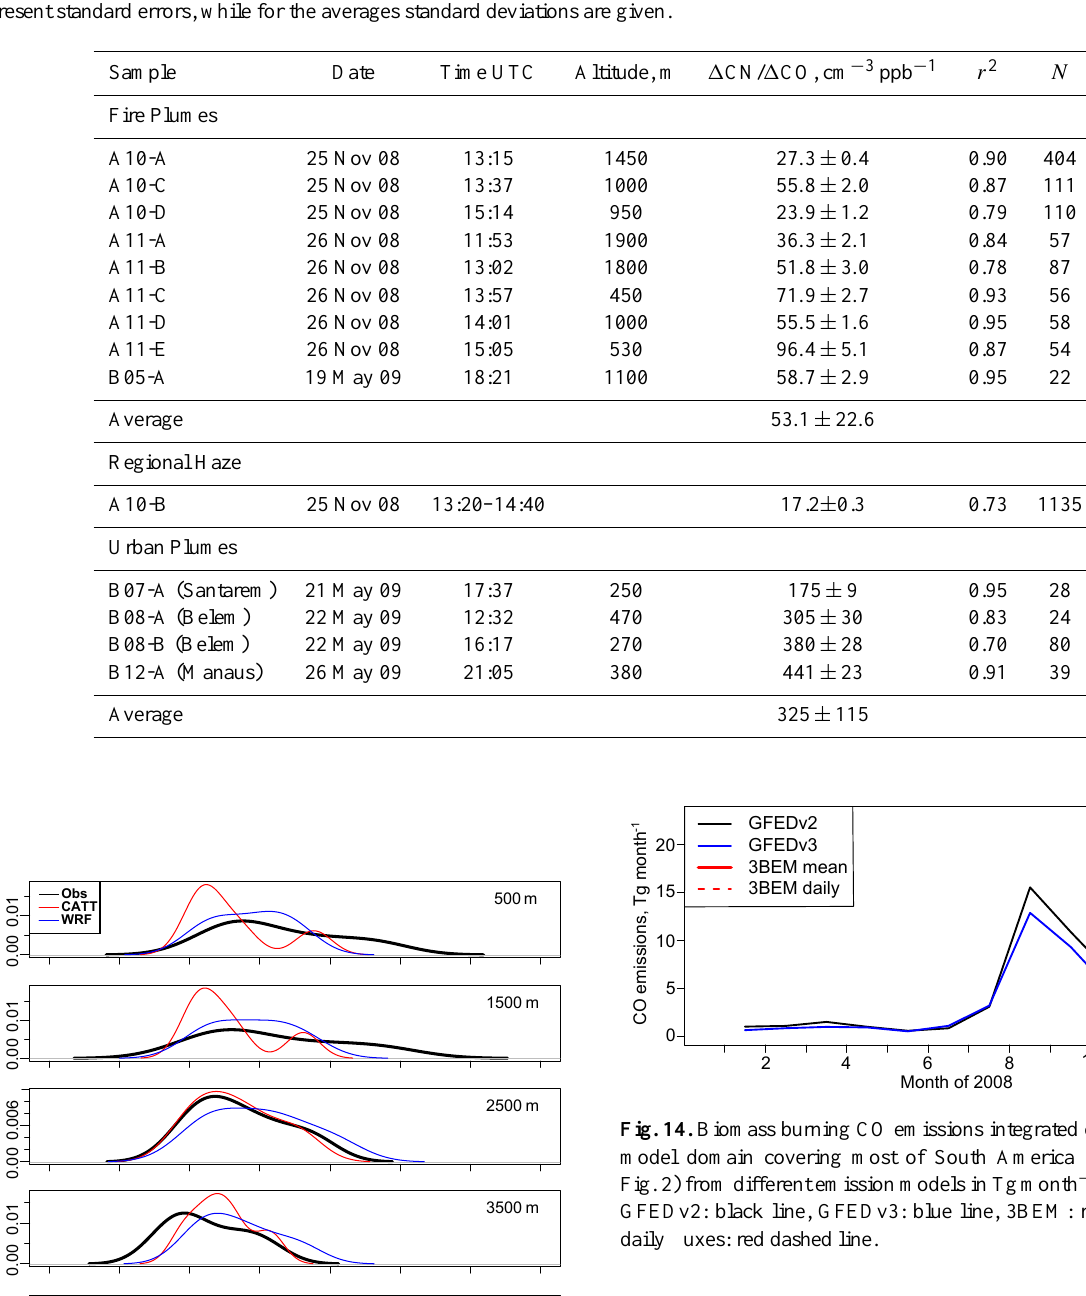
Table 3. Emission ratios 1 CN/ 1 CO measured during the BARCA campaign flights. The error values given for the individual plumes represent standard errors, while for the averages standard deviations are given.